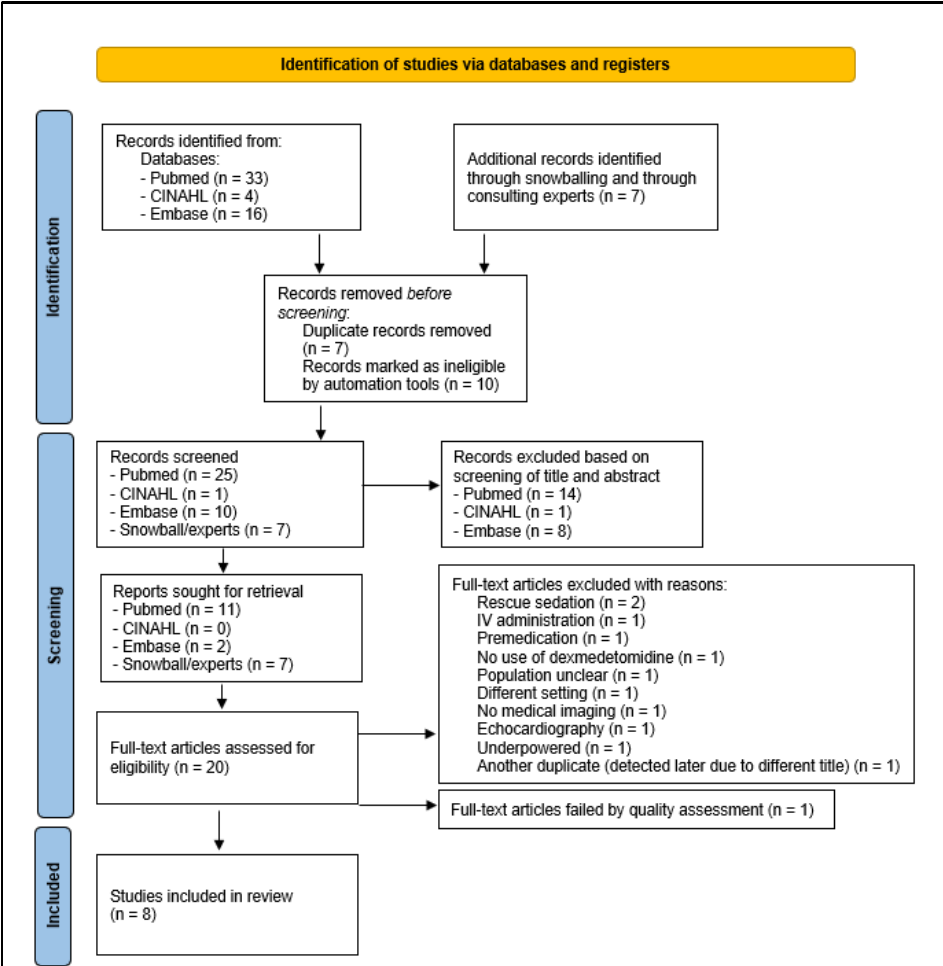
Figure 1. PRISMA 2020 flow diagram [16].